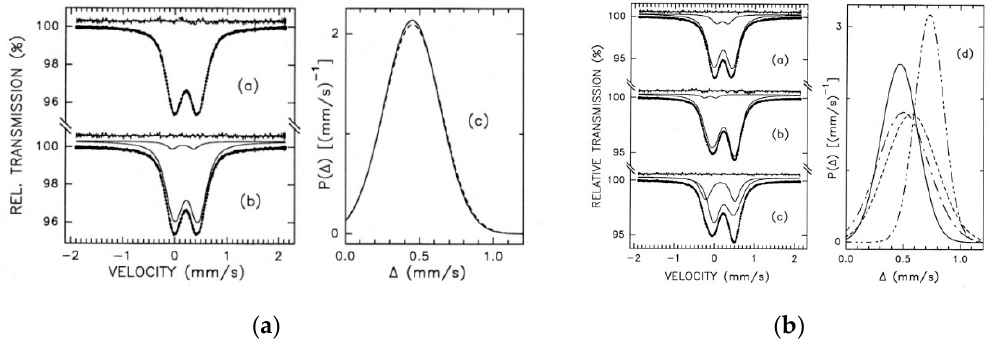
Figure 20. Mössbauer spectra of Al 60 Ge 20 Cr 19.9 Fe 0.1 ( a ) and of Al 75 Cu 14.85 Fe 0.15 V 10 ( b ) alloys and corresponding QS distributions. Reproduced from [53].